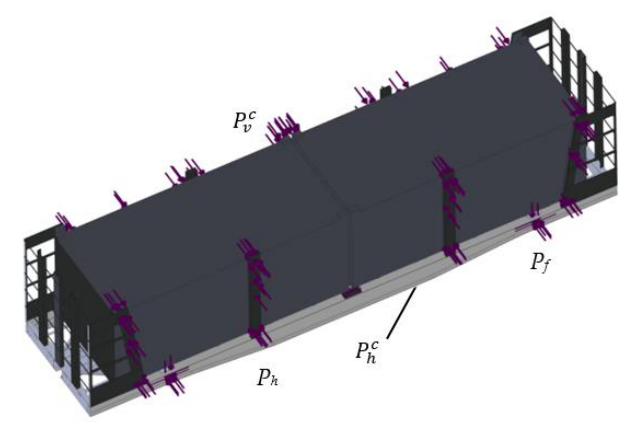
Figure 6. Design scheme of the load-bearing structure of the flat wagon with a container.